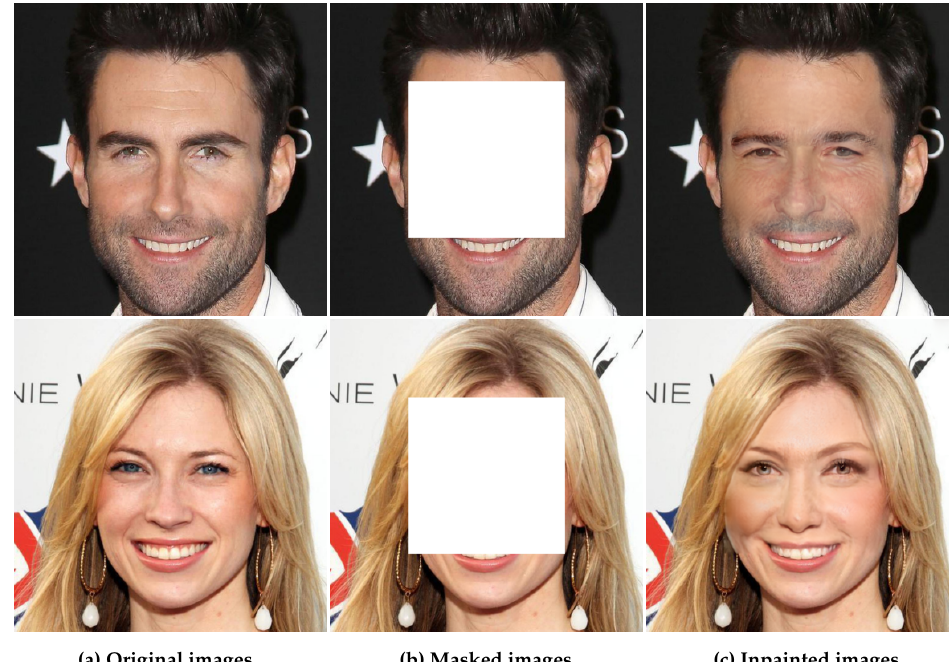
Figure 1. Examples of the repair results of our